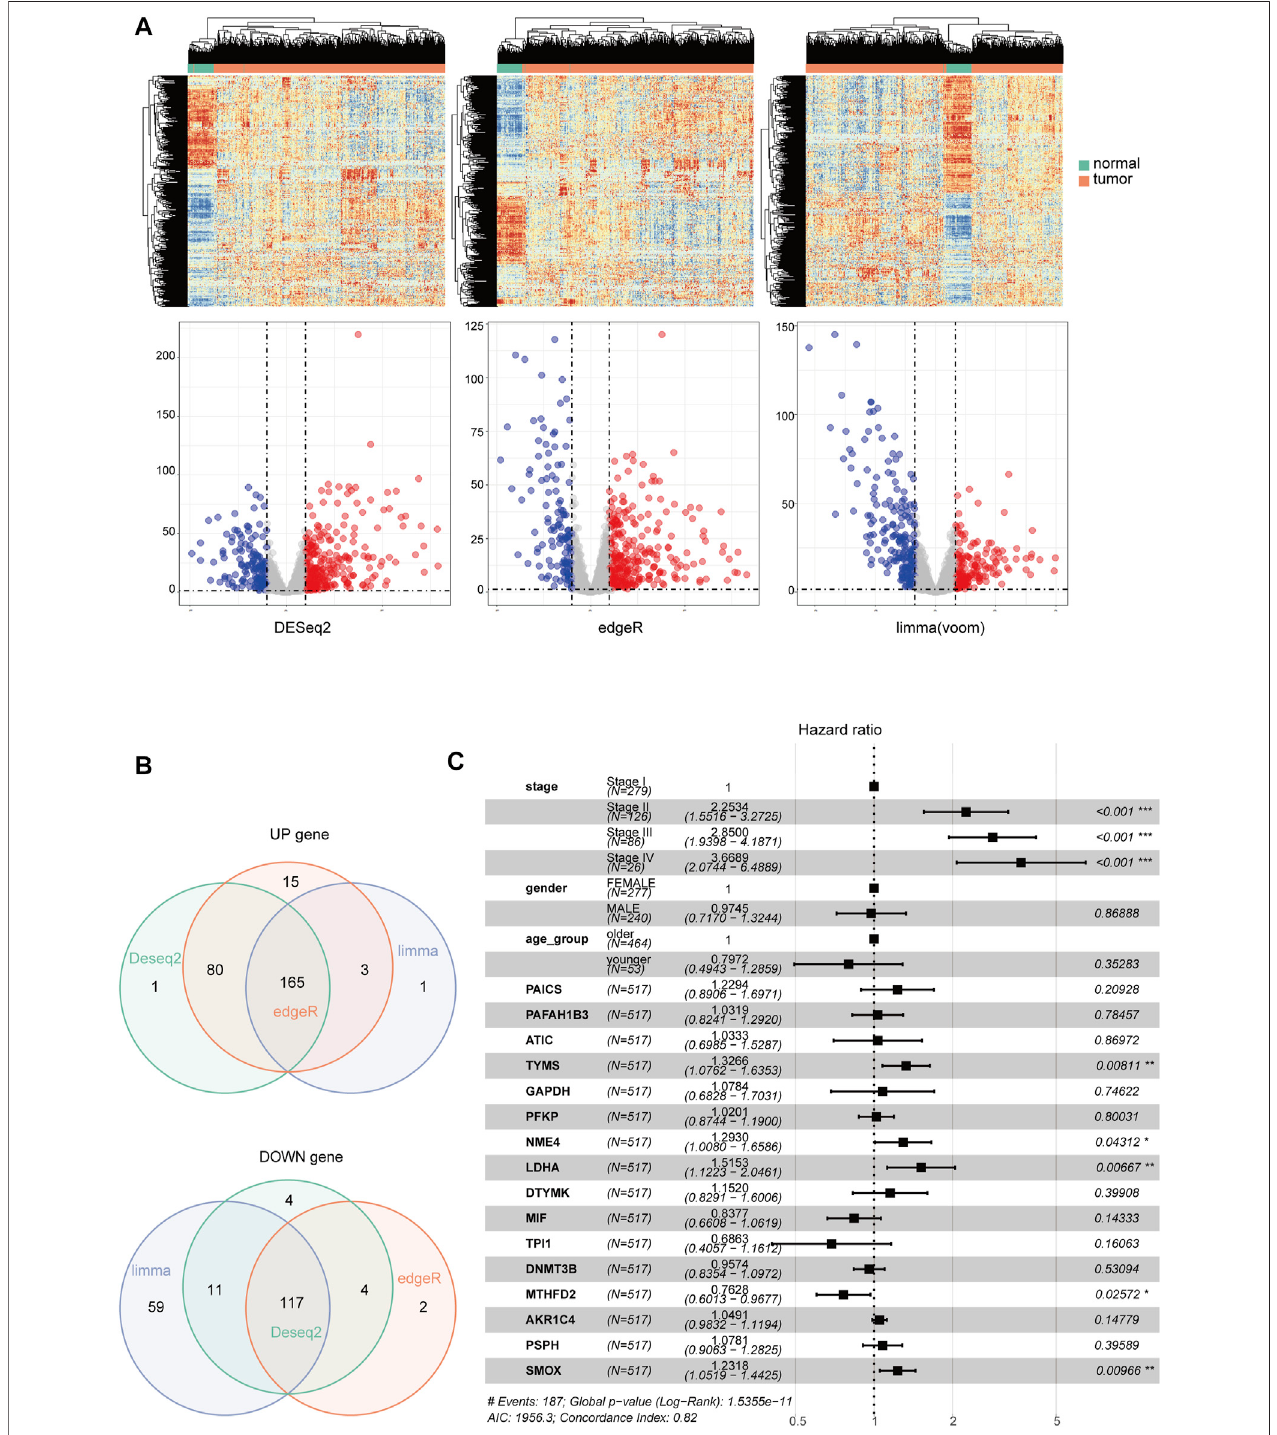
FIGURE2| Theidenti fi cationofdifferentially-expressedmetabolicgenes.Heatmap andVolcanoPlot (A) ,VennDiagram (B) compared theresultsof3 Rpackages ‘ DESeq2, ’ ‘ edgeR, ’ and ‘ limma ’ . respectively. (C) A forest map showed 16 metabolic enzyme genes identi fi ed by Multivariate Cox Proportional Hazards Regression analysis. Signi fi cance codes: < 0.001 (cid:1) ppp , < 0.01 (cid:1) pp , and < 0.05 (cid:1) p .